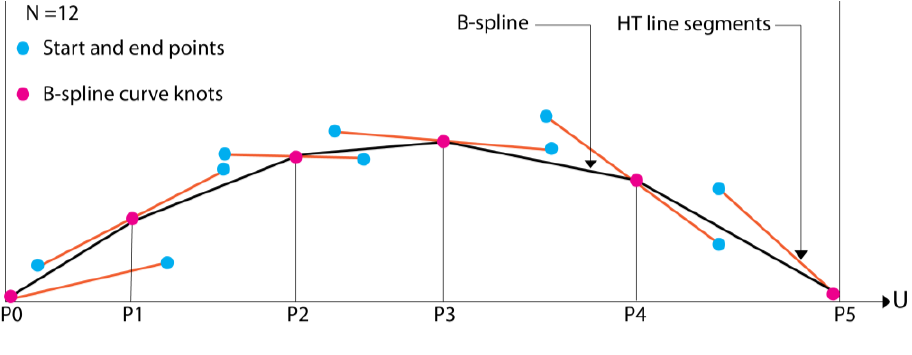
Figure 7. Approximation of line segments into a smooth curve using